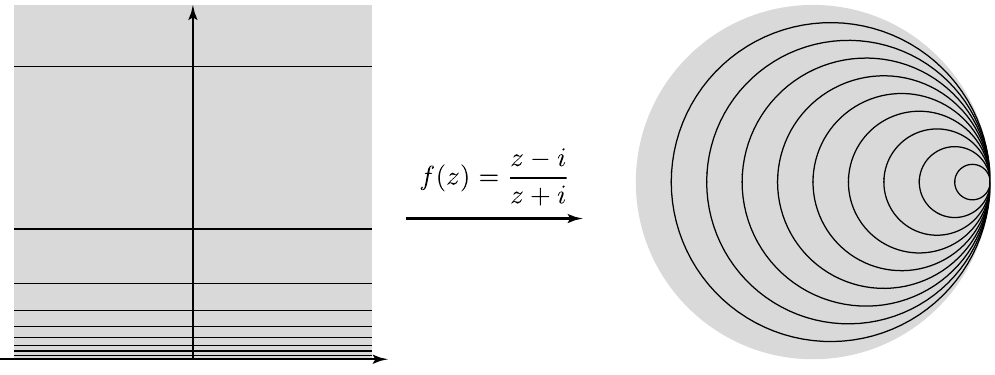
Figure 3 . The Cayley transformation is a bijection between the upper-half plane (left) and the Poincar(cid:19)e disk